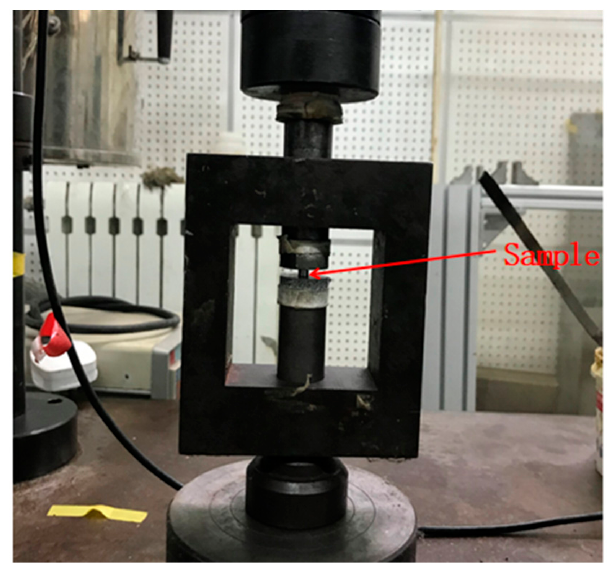
Figure 2. Sample clamping drawing.